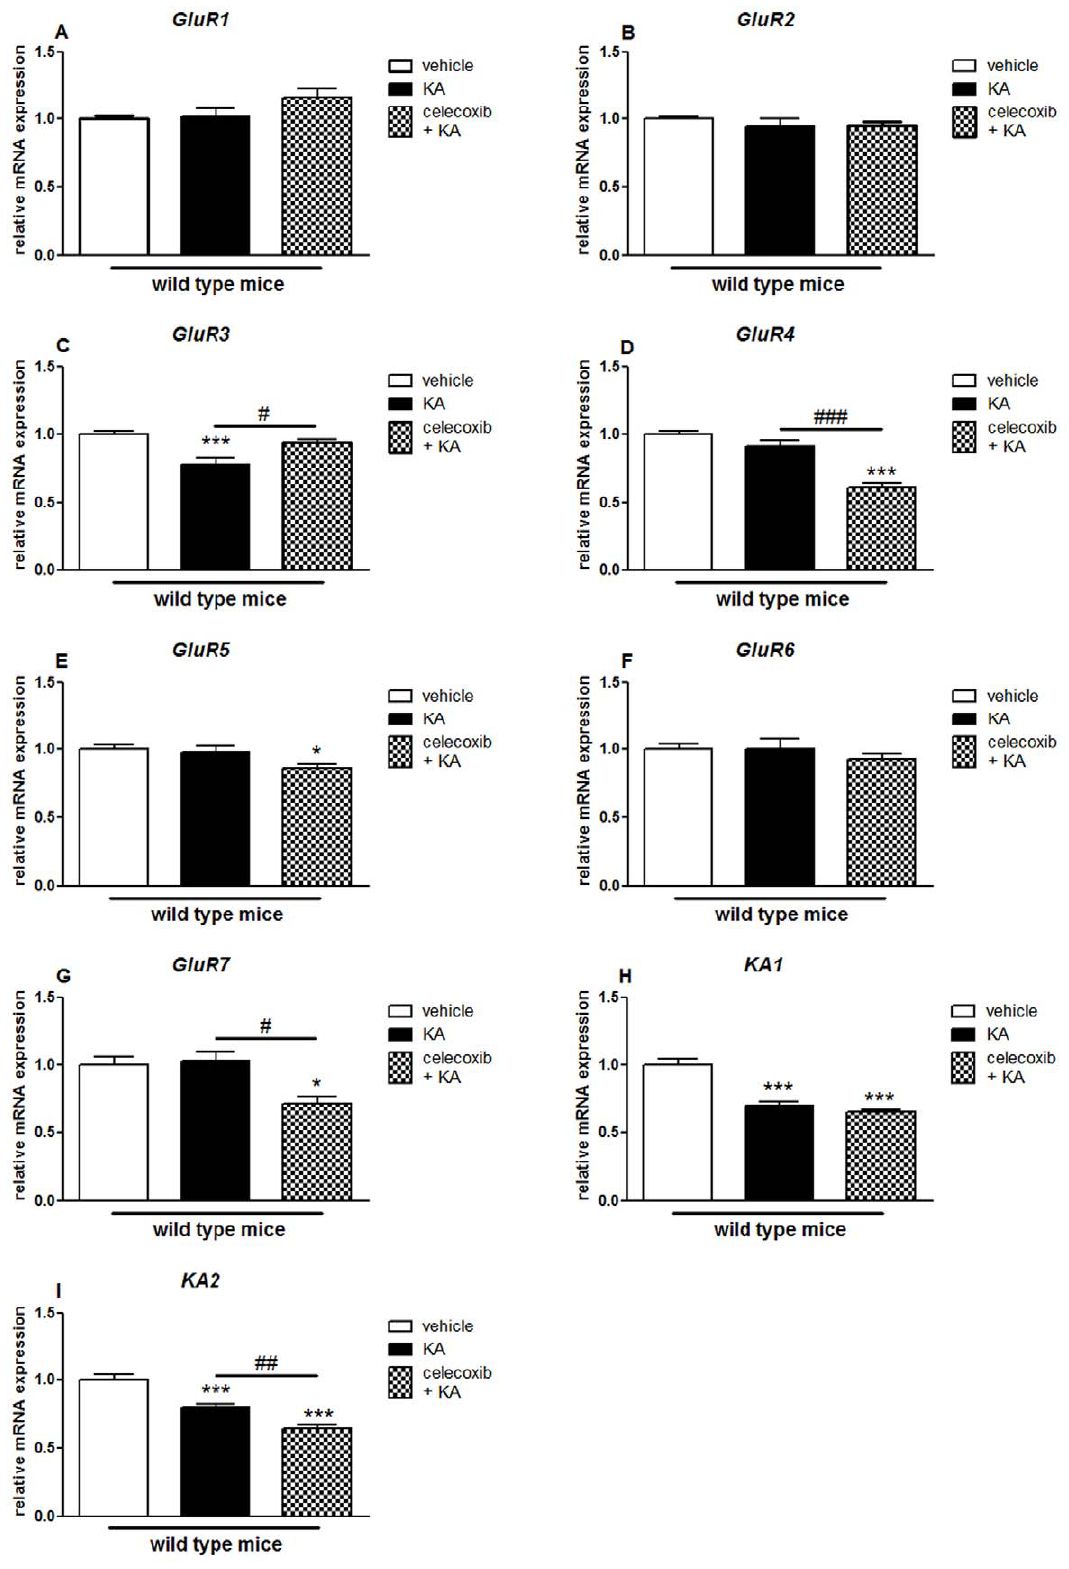
Figure 6. Effects of pretreatment with celecoxib on KA-induced expression of AMPA/KA receptor subunits in the cortex of wild type mice. Quantitative real time-PCR analysis of GluR1 (A), GluR2 (B), GluR3 (C), GluR4 (D) in WT mice, after two weeks treatment with celecoxib, followed by an i.p. injection of KA or vehicle 24 hours later. Data are means 6 SEM ( n =9). Statistical analysis was performed using a one-way ANOVA and Bonferroni’s post-hoc test. *P , 0.05, **P , 0.01, *** P , 0.001 compared to vehicle-injected WT mice; # P , 0.05, ## P , 0.01, ### P , 0.001 compared to KA-injected WT mice. doi:10.1371/journal.pone.0019398.g006 PLoS ONE |